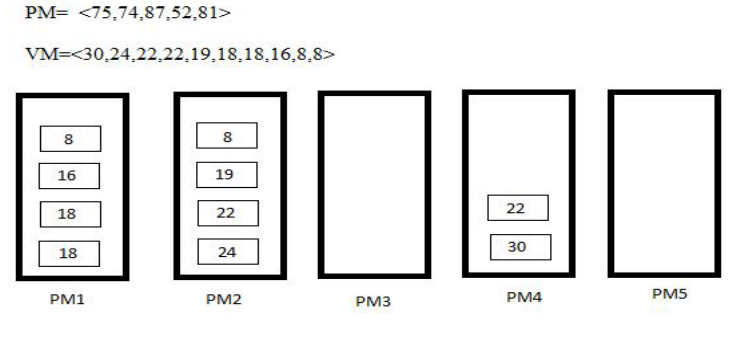
Figure 1. VM placement by Best-Fit